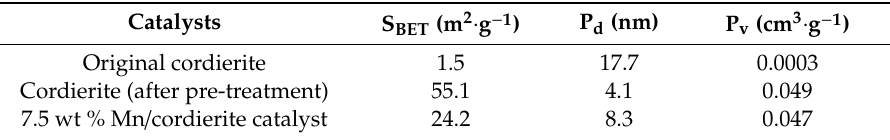
Table 1. The specific surface area and pore structure of catalysts.